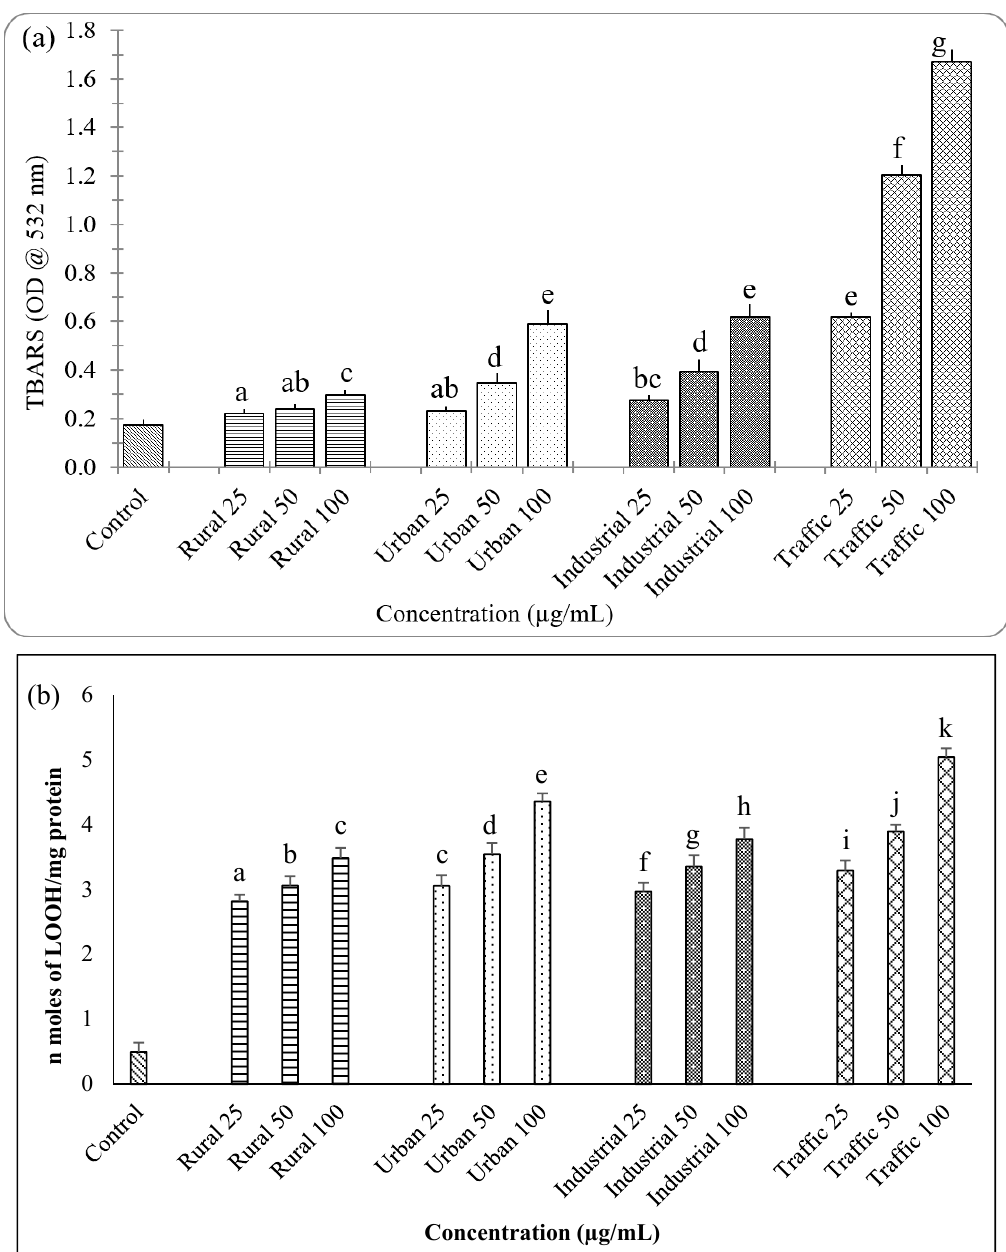
Figure 2. Thiobarbituric acid-reactive species (TBARS) ( a ) and lipid hydroperoxides (LOOH) ( b ) measured in A549 cells treated with PM 2.5 samples. N = 3 ± SD, Dataset not sharing common superscript vary significantly p < 0.05 (DMRT).